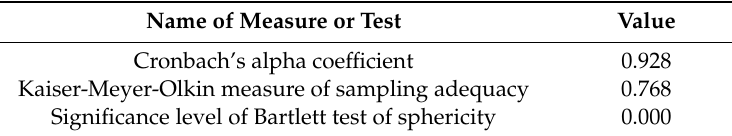
Table A6. Analysis of reliability and validity of the collected questionnaire data about the user interaction satisfaction of using the interactive